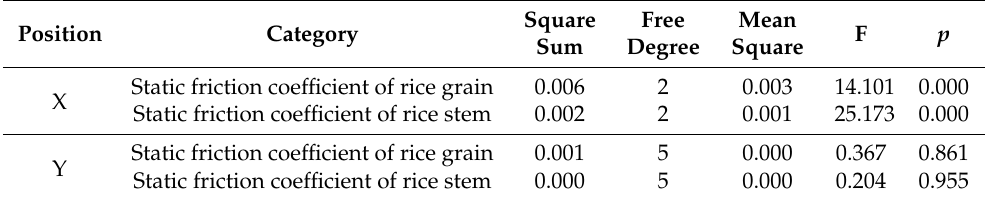
Table 4. ANOVA results of the static friction coefficients of rice grains and stems.